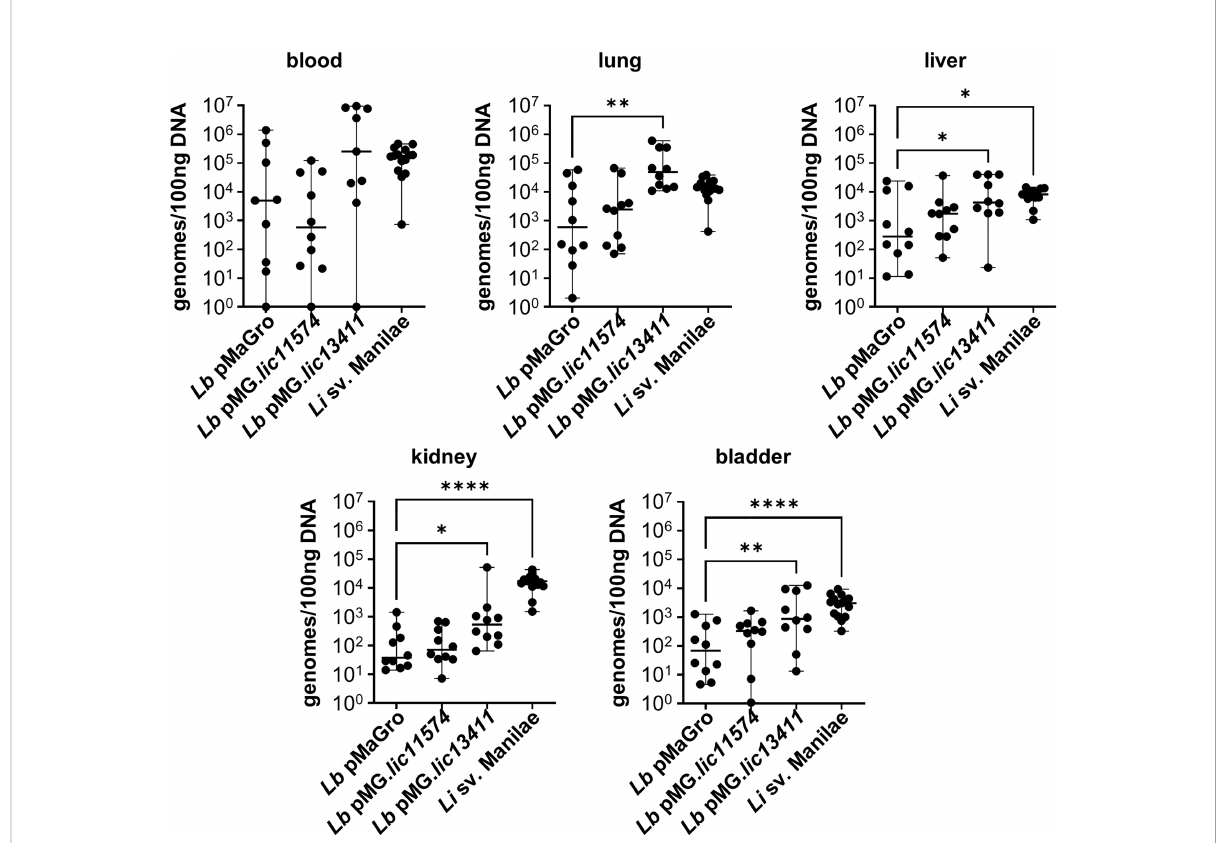
FIGURE 6 LIC13411 increases bacterial burdens in the lung, liver, kidney, and bladder. Mice were inoculated intravenously in a 1 h model of infection. DNA from organs was harvested and quanti fi ed by qPCR. Signi fi cantly higher burdens of L. bi fl exa pMG. lic13411 were found in the lung, liver, kidney, and bladder relative to the non-pathogenic control strain. The burden of L. bi fl exa pMG. lic13411 in the bladder is similar to the burden of pathogenic L. interrogans sv. Manilae. Data represent a total of 10 mice per group (except for blood samples with L. bi fl exa pMaGro and L. bi fl exa pMG. lic13411 where n = 9), performed as two independent experiments per strain. Data for L. interrogans sv. Manilae originally appears in an article published in this issue of Frontiers in Cellular and Infection Microbiology and represents three independent experiments per strain with 15 mice per group (except for liver where n = 13) (Surdel et al., 2022). Median ± range is plotted. Each group is compared to the L. bi fl exa pMaGro control. *denotes p ≤ 0.05, **denotes p ≤ 0.01, ****denotes p ≤